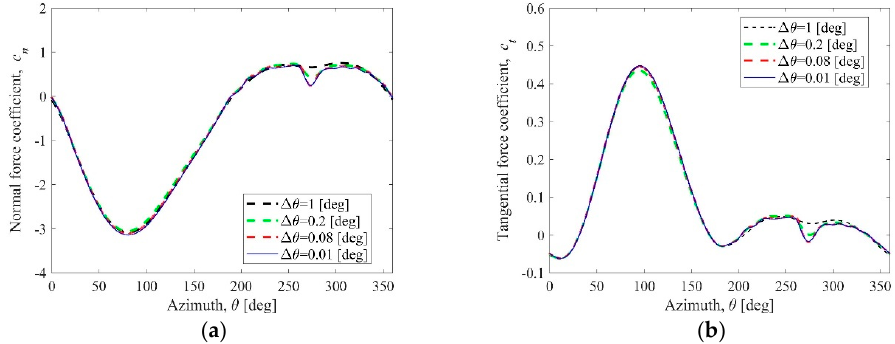
Figure 16. Influence of the time step size that corresponds to the angle step size Δθ on the aerodynamic blade loads: ( a ) normal and ( b ) tangential.